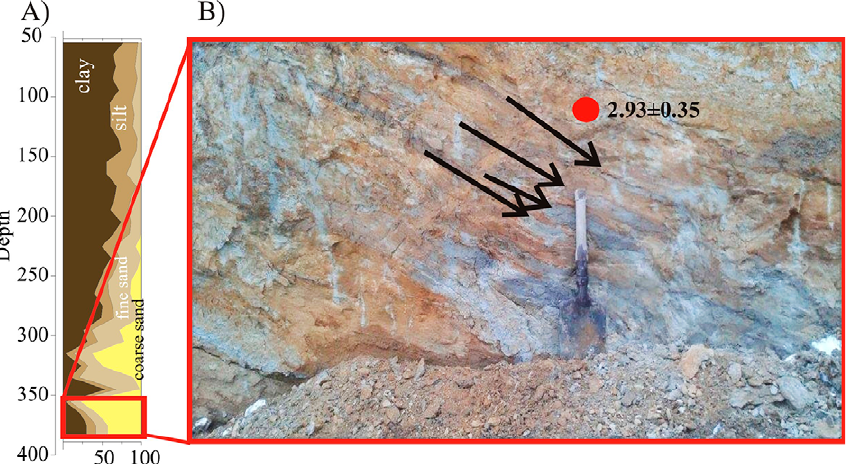
age of the sediments.